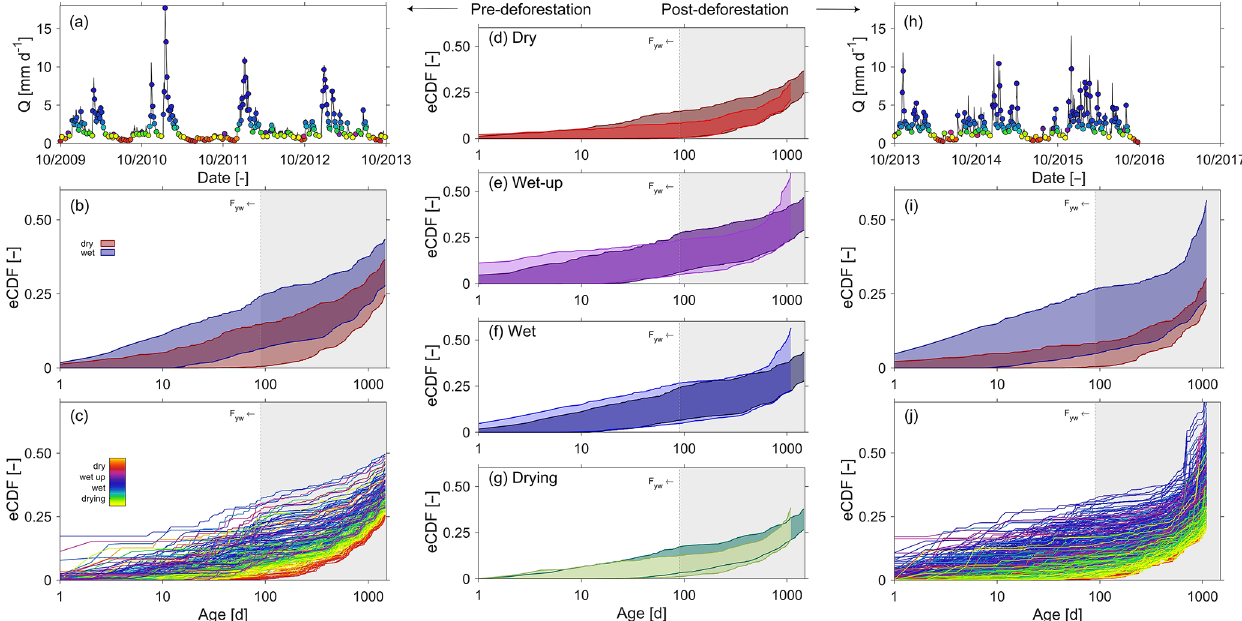
Figure 9. Panels in the left-hand-side column show pre-deforestation (a) discharge, and the coloured dots indicate to which period (dry, wet-up, wet, drying) the individual selected time steps belong; (b) the 5th / 95th percentiles of the empirical cumulative TTDs for wet (blue) and dry (red) periods, respectively; (c) the ensemble of the individual TTDs at the time steps indicated in (a) . Panels in the middle column (d–g) compare the 5th / 95th percentiles of empirical cumulative TTDs between pre-deforestation (dark shades) and post-deforestation (light shades) periods for dry, wet-up, wet and drying conditions, respectively. Panels in the right-hand-side column show post-deforestation (h) discharge, and the coloured dots indicate to which period (dry, wet-up, wet, drying) the individual selected time steps belong; (i) the 5th / 95th percentiles of the empirical cumulative TTDs for wet (blue) and dry (red) periods, respectively; (j) the ensemble of the individual TTDs at the time steps indicated in (h) . All distributions shown are truncated at 3 (post-deforestation) or 4 years (pre-deforestation), which coincides with the tracked periods. For the remaining fractions, i.e. the difference to 1, it can only be said that they are older than 3 or 4 years but nothing more than that. The grey shaded areas indicate regions with ages > 3 months, thereby exceeding F yw